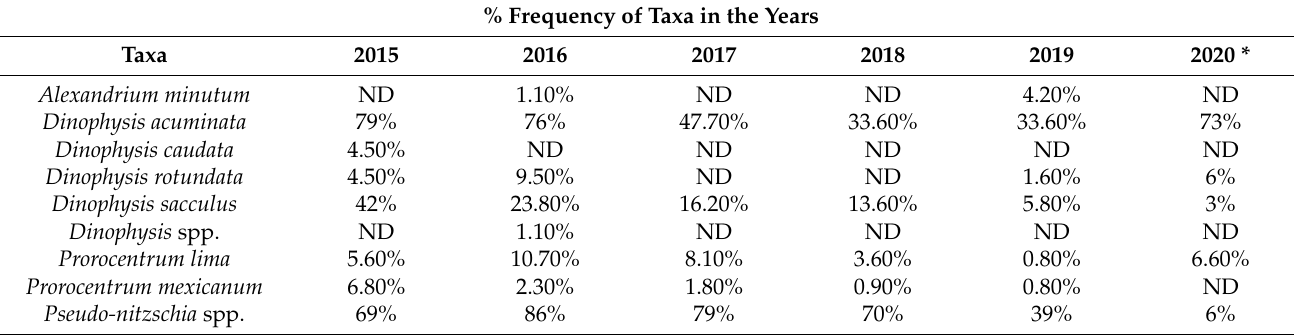
Table 3. Frequency of potentially toxic taxa expressed as a percentage found in shellfish farming waters in the Sardinia region, years 2015–2020.